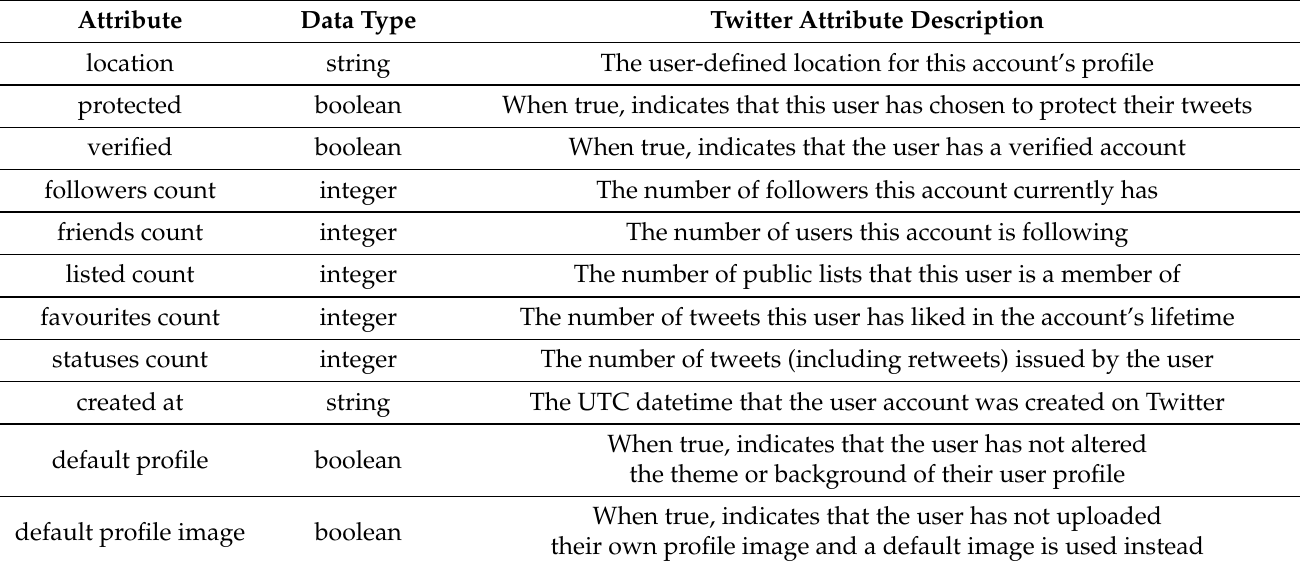
Table 7. Twitter account user information used for classification with the RF Fake News Spreader Classifier described in Section